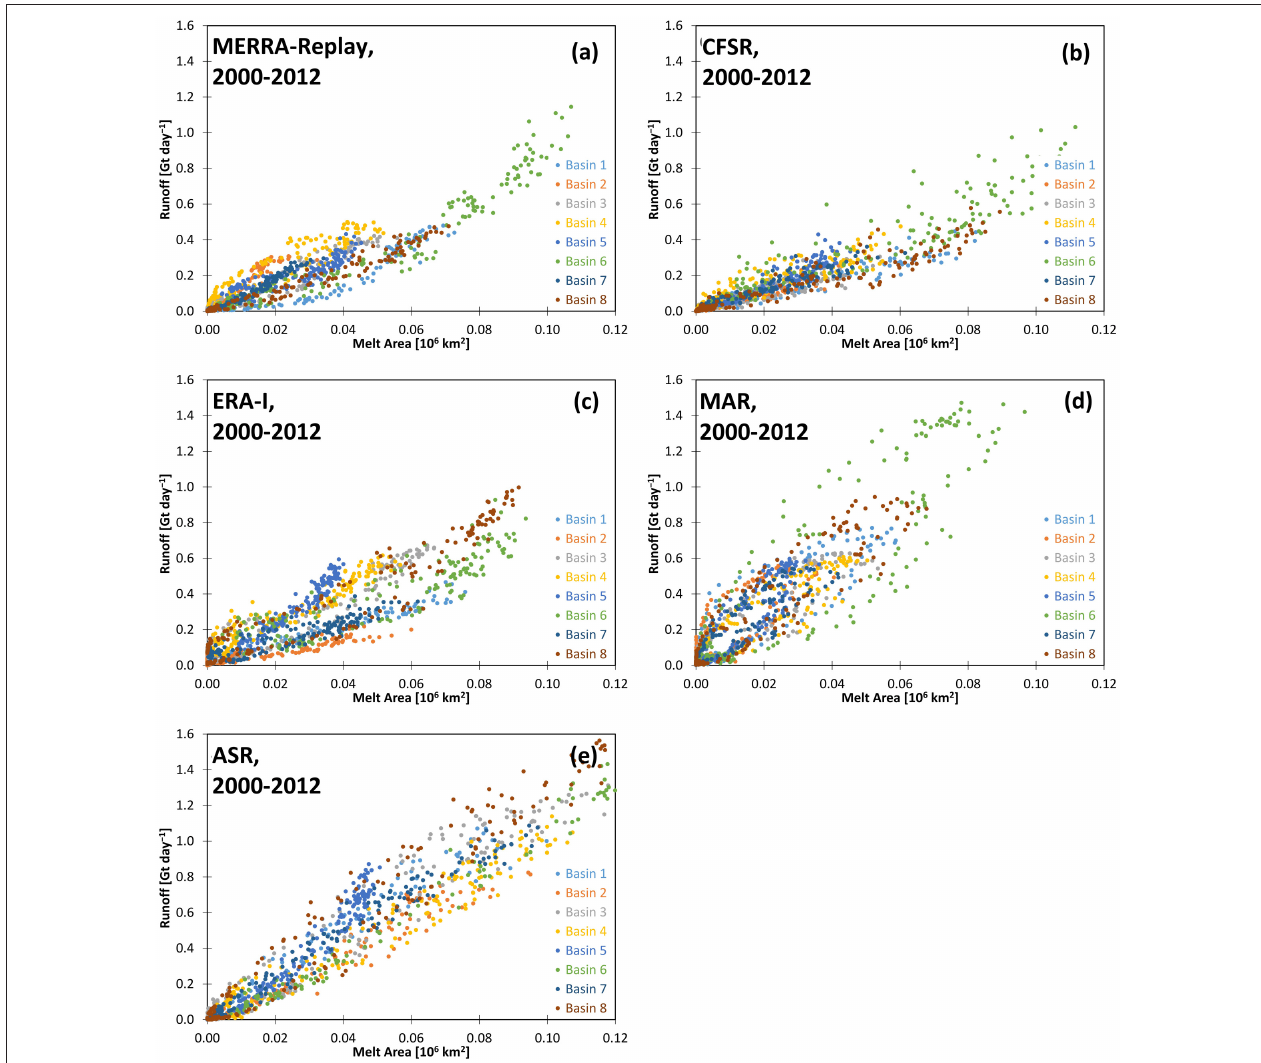
FIGURE 11 | Daily runoff in Gt day − 1 vs. melt area in 10 6 km 2 , averaged for the period 2000-2012 from (A) MERRA-replay (B) CFSR (C) ERA-I, (D) MAR, and (E)